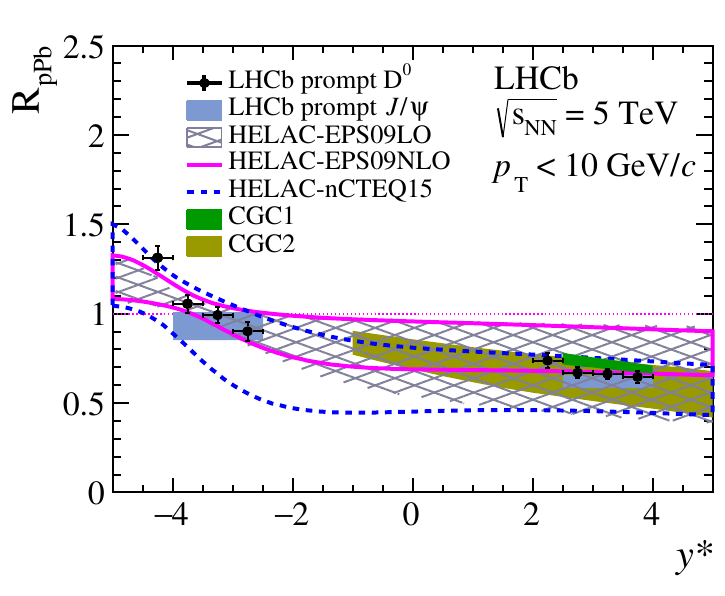
Figure 6 . Nuclear modi(cid:12)cation factor R p Pb as a function of y (cid:3) for prompt D 0 meson production, integrated up to p T = 10 GeV =c and compared to the J= measurement in the same kinematic region and to the theoretical models discussed in the text. The uncertainty is the quadratic sum of the statistical and systematic